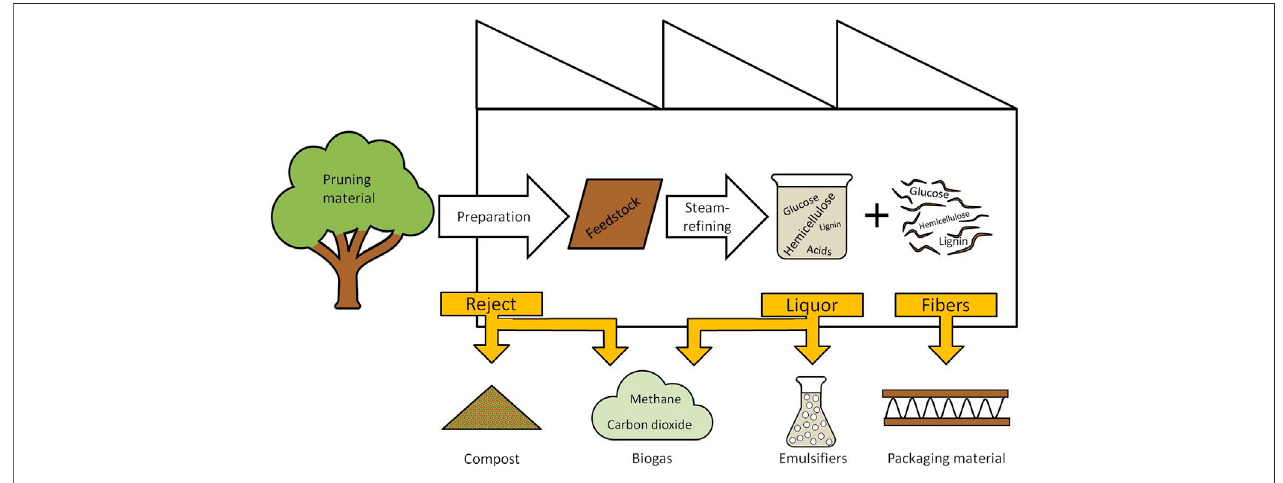
FIGURE 1 | Flowchart of the tree pruning residue processing zero-waste biore fi nery.